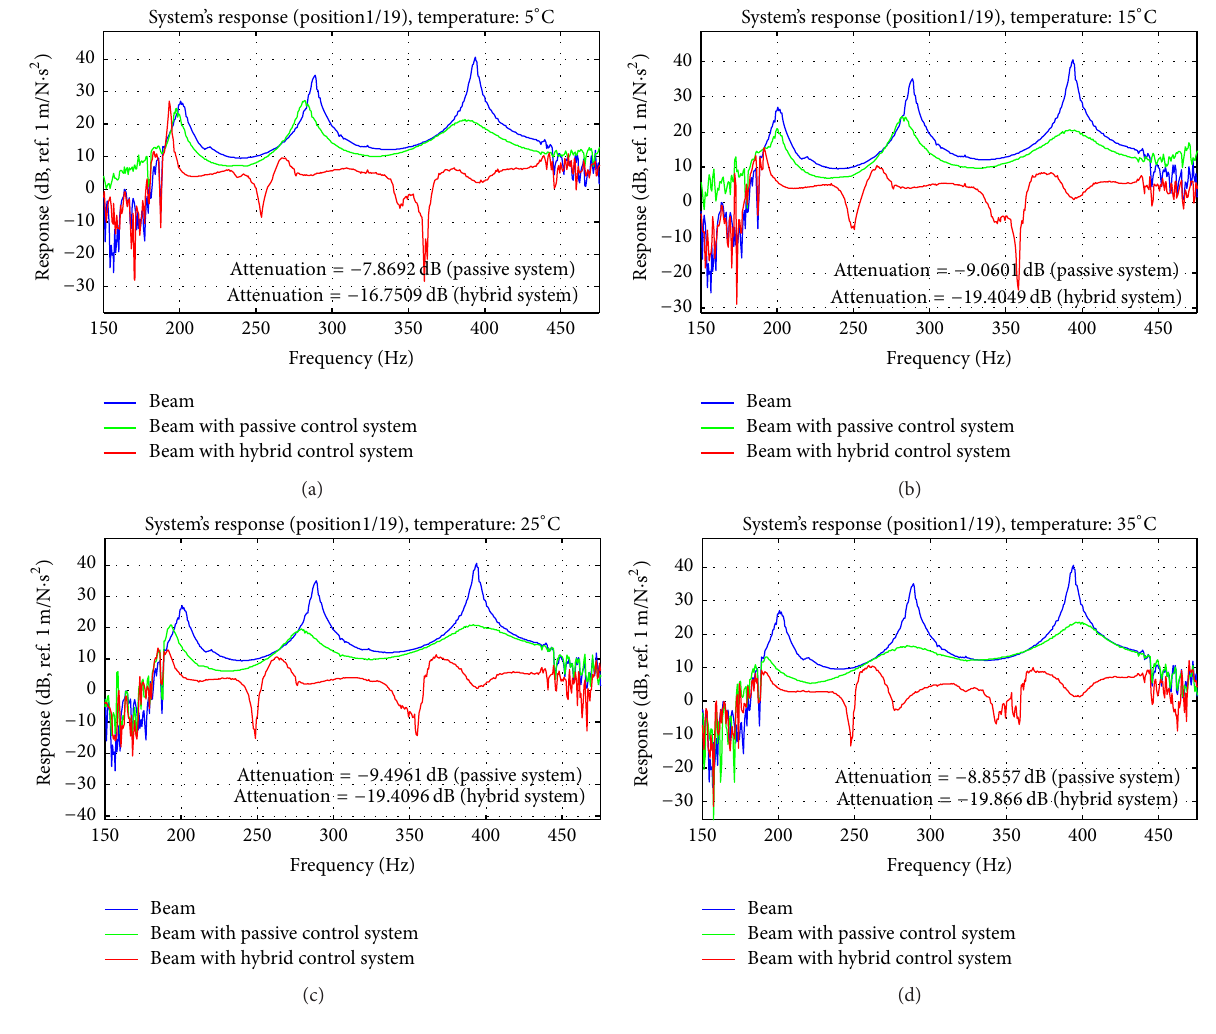
Figure 12: PVCS and HVCS performances at (a) 𝑇 = 5 ∘ C, (b) 𝑇 = 15 ∘ C, (c) 𝑇 = 25 ∘ C, and (d) 𝑇 = 35 ∘ C.